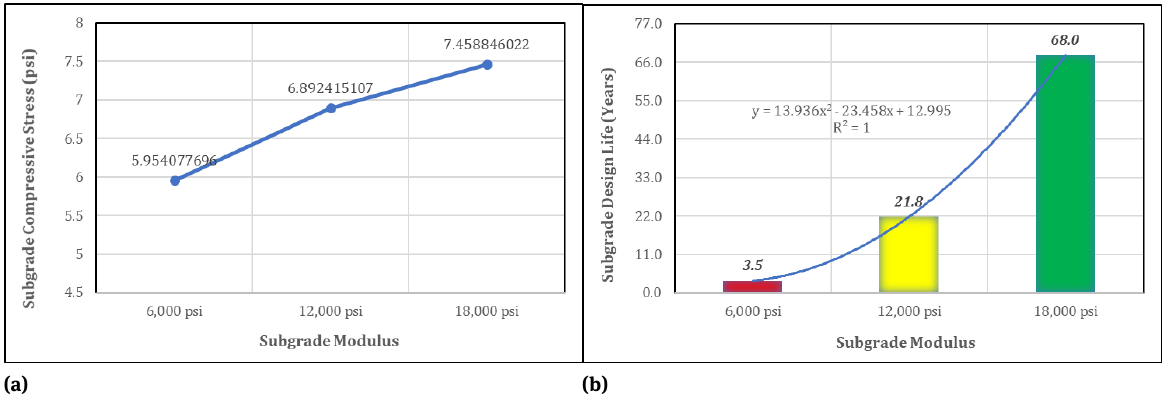
Figure 25: Influence of subgrade modulus on subgrade compressive stress (a) and on subgrade service life (b) in asphaltic overlayment track.